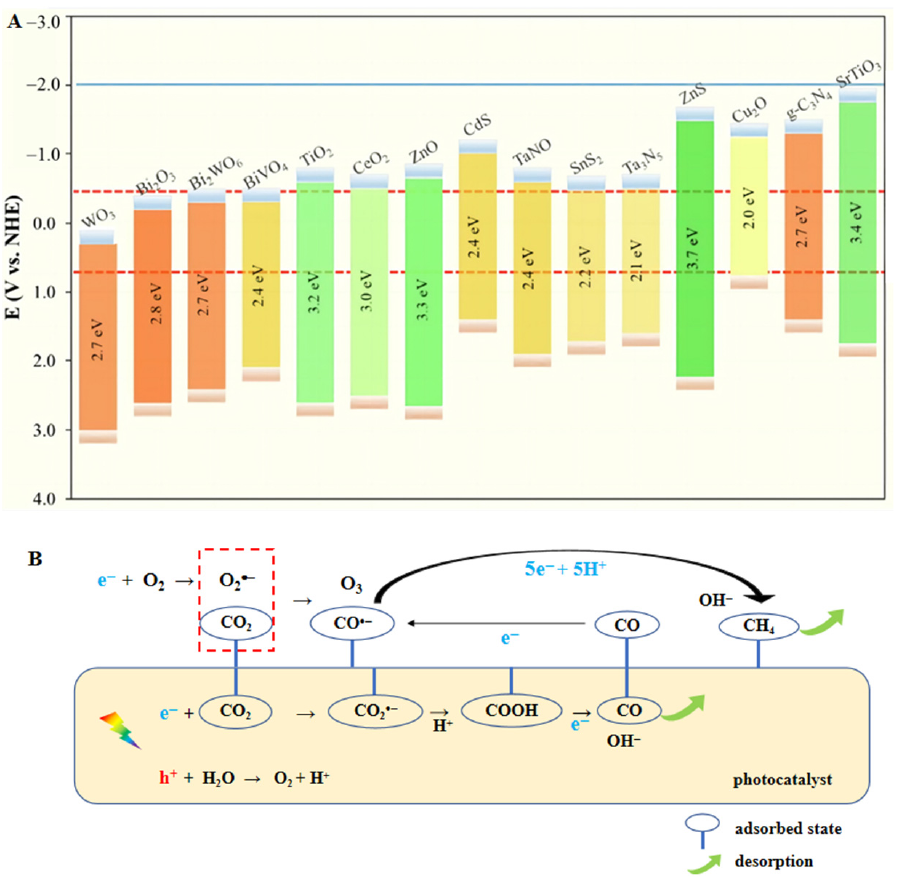
Figure 2. ( A ) Band edge positions of various semiconductors in relation to the redox potential of different products at pH = 7 [11]. ( B ) Schematic illustration of the mechanism for CH 4 /CO generation. Therefore, enough e − and H + are requisites for the entire photoreduction process. A series of fuels can be obtained by means of well-designed catalysts, such as CH 4 [12,13], CH 3 OH [14] and HCOOH [15]. It makes sense to create valuable solar fuel from CO 2 , which provides a solution to environmental pollution. Products, alcohols, hydrocarbons and even carbon monoxide can be used as feedstock for energy reserves or high-value compounds. reduction pace, with detailed information being presented sequentially